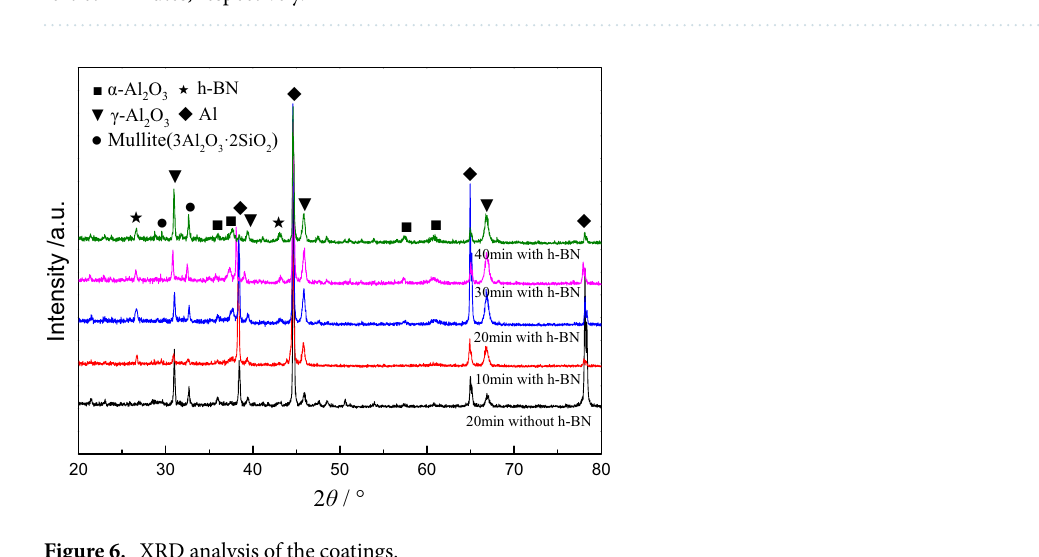
Figure 5. Cross-section morphology of the coatings. Subfigures ( a ),( c ),( e ) and ( g ) are the surfaces of the coating without h-BN particles in the tenth, twentieth, thirtieth and fortieth minutes, respectively; Subfigures ( b ),( d ),( f ) and ( h ) are the surfaces of the coating containing h-BN particles in the tenth, twentieth, thirtieth and fortieth minutes, respectively.